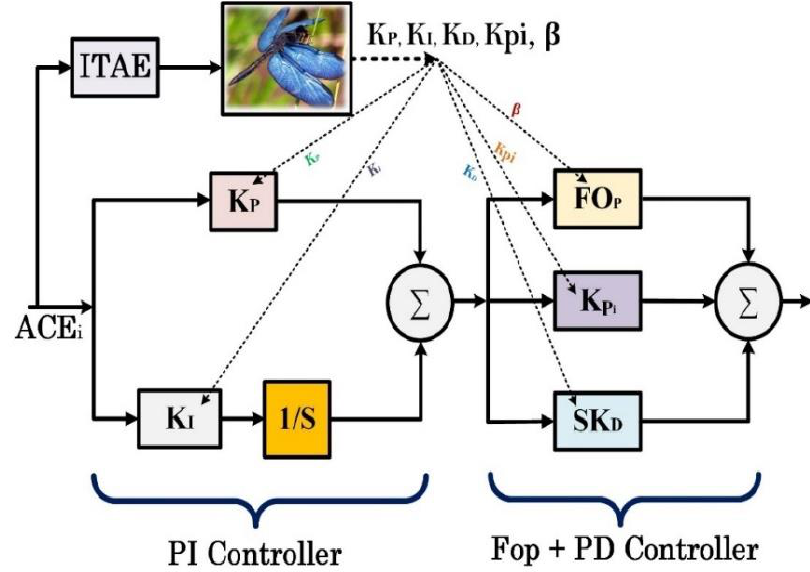
Figure 3. Proposed controller topology .